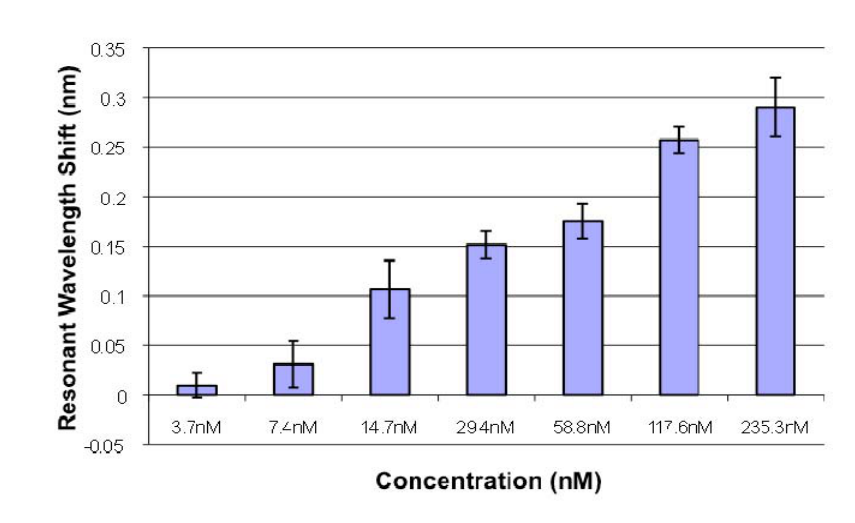
Figure 3. Sensor response (TM-polarization) for detection of TNF in buffer solution with immobilized anti-TNF antibodies bound to the sensor